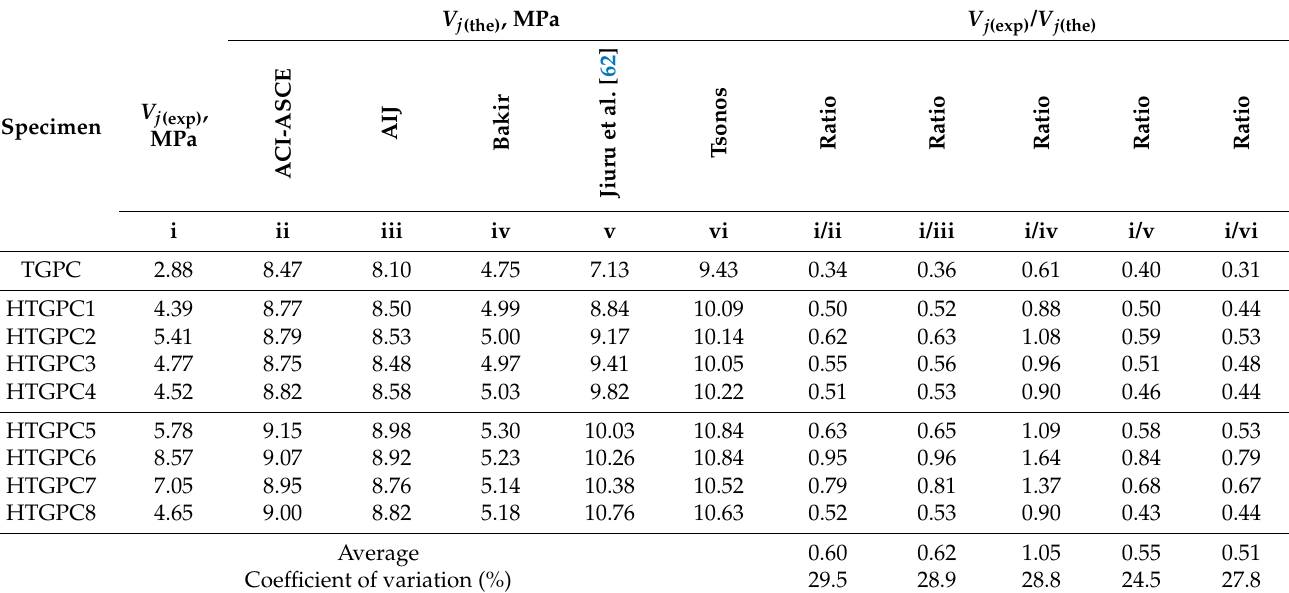
Table 4. Experimental and theoretical values